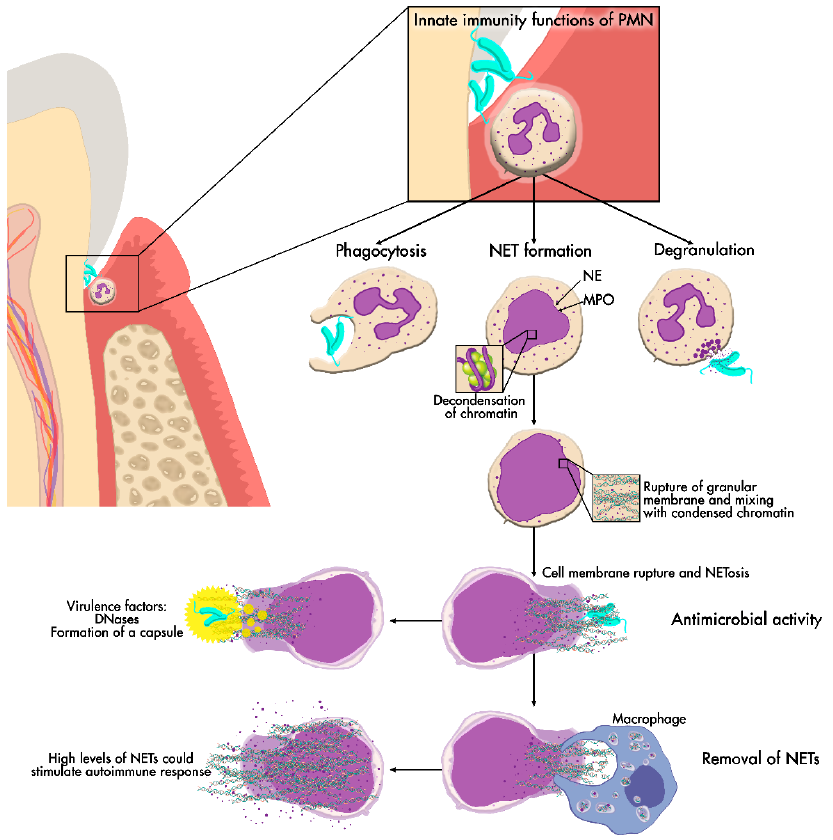
Figure 3. NET release. NET formation may be one of the main neutrophil functions in periodontal tissue. NET production starts with chromatin decondensation, which is then embedded with cytoplasmic antimicrobial peptide granules. NETs are then released into the extracellular space after rupture to exert their antimicrobial e ff ect and later removed from the tissue. If NET removal fails, cell membrane rupture to exert their antimicrobial effect and later removed from the tissue. If NET persistent high levels of NETs could cause damage to periodontal removal fails, persistent high levels of NETs could cause damage to periodontal tissues.